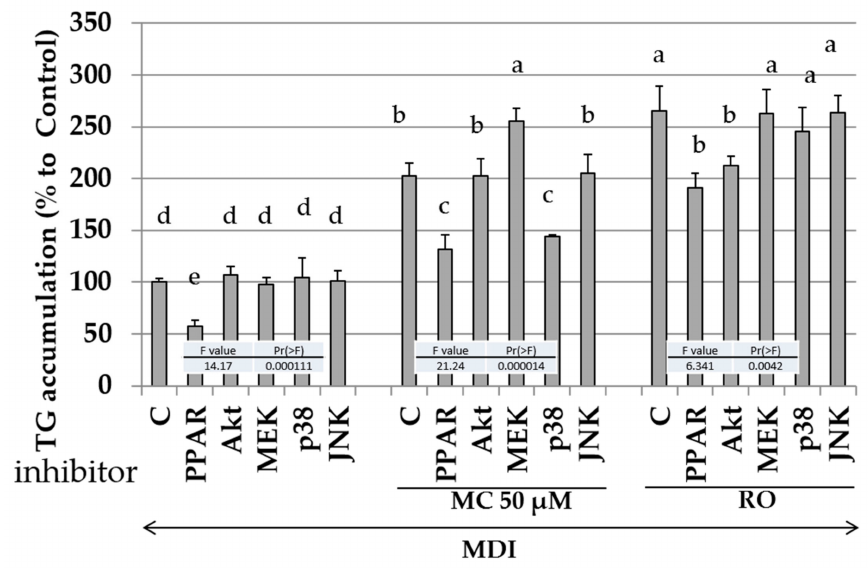
Figure 7. The e ff ects of each inhibitor on the lipid levels in 3T3-L1 cells during adipogenesis. B (Black): Undi ff erentiated cells without the addition of the MDI, PPAR: cells with MDI and bisphenol A diglycidyl ether, AKt: cells with MDI and wortmannin, MEK: cells with MDI and U0126, p38: cells with MDI and SB202190, and JNK: cells with MDI and JNK inhibitor. The data are presented as the mean ± SD from three independent experiments. The arrow indicates the addition of the MDI mixture. The same letters indicate that there are no di ff erences between those groups, and di ff erent letters indicate significant di ff erences ( P <